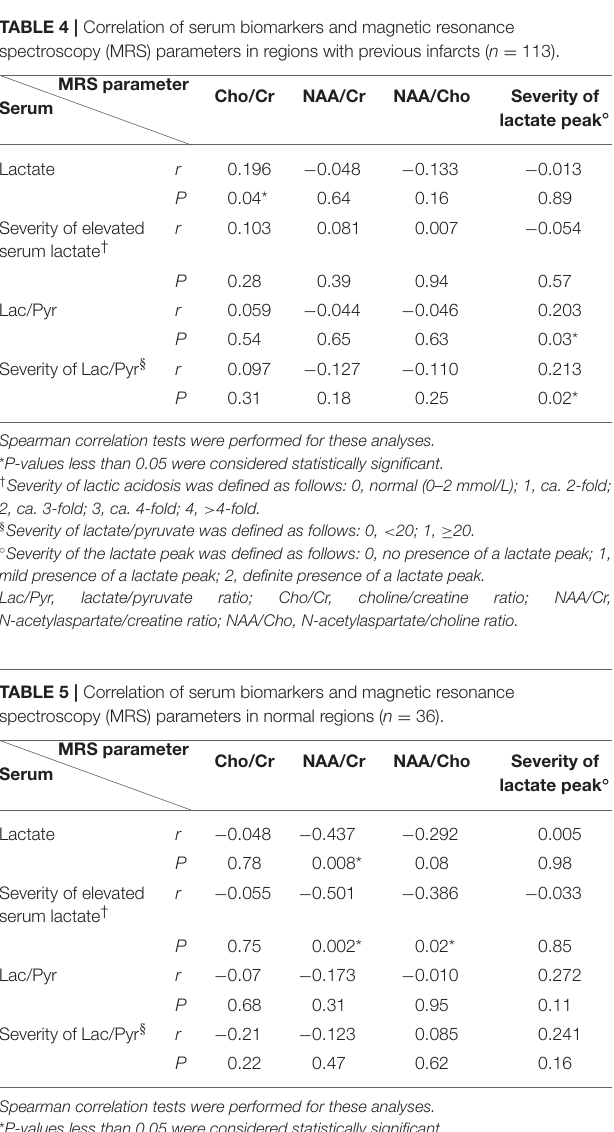
TABLE 4 | Correlation of serum biomarkers and magnetic resonance spectroscopy (MRS) parameters in regions with previous infarcts ( n = 113). MRS parameter Serum